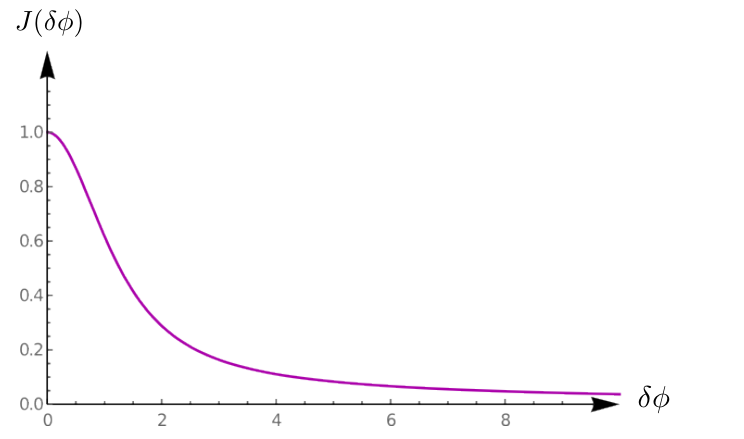
Figure 3 . The Janus correction function, J , de(cid:12)ned in equation